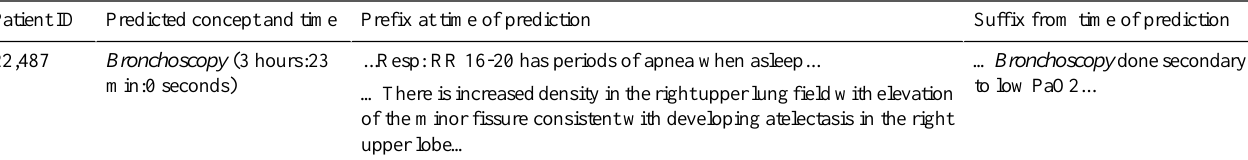
Table 4. Predictions and explanations provided to our medical student and physician authors to label the clinical significance of a prediction.